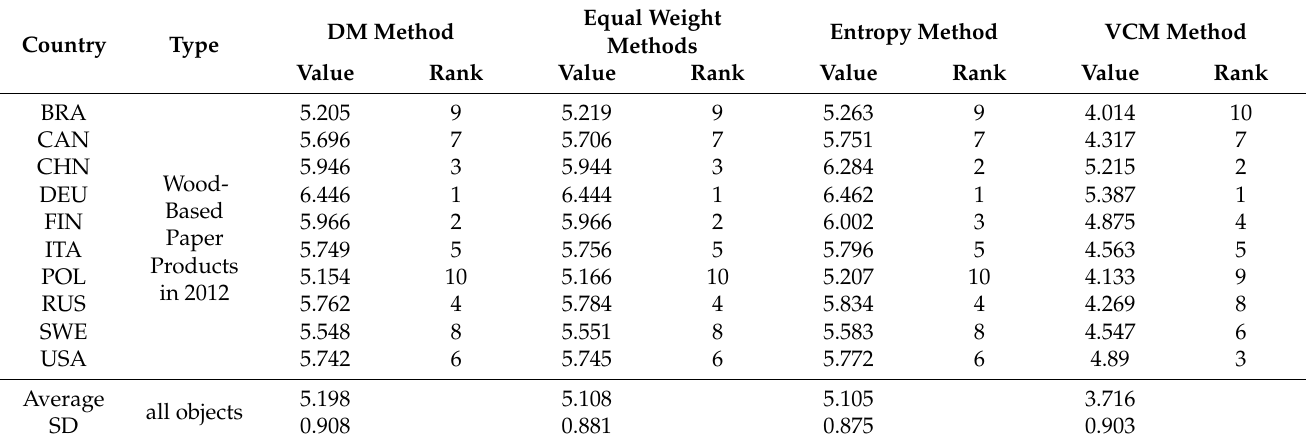
Table 10. The values obtained by the DM method and the other three methods—wood-based paper products in 2021 as an